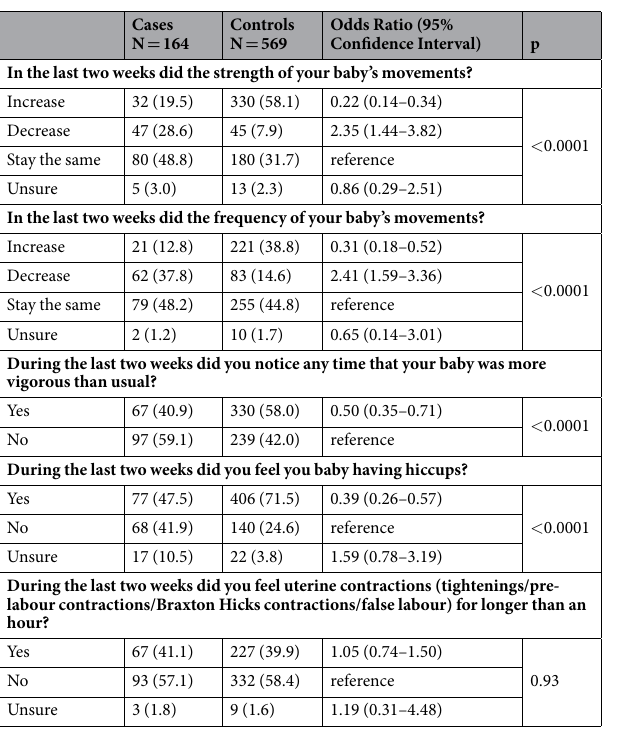
Table 2. Univariable analysis of fetal movement strength, frequency and odds of late stillbirth. Where column numbers do not add up to N this is due to missing